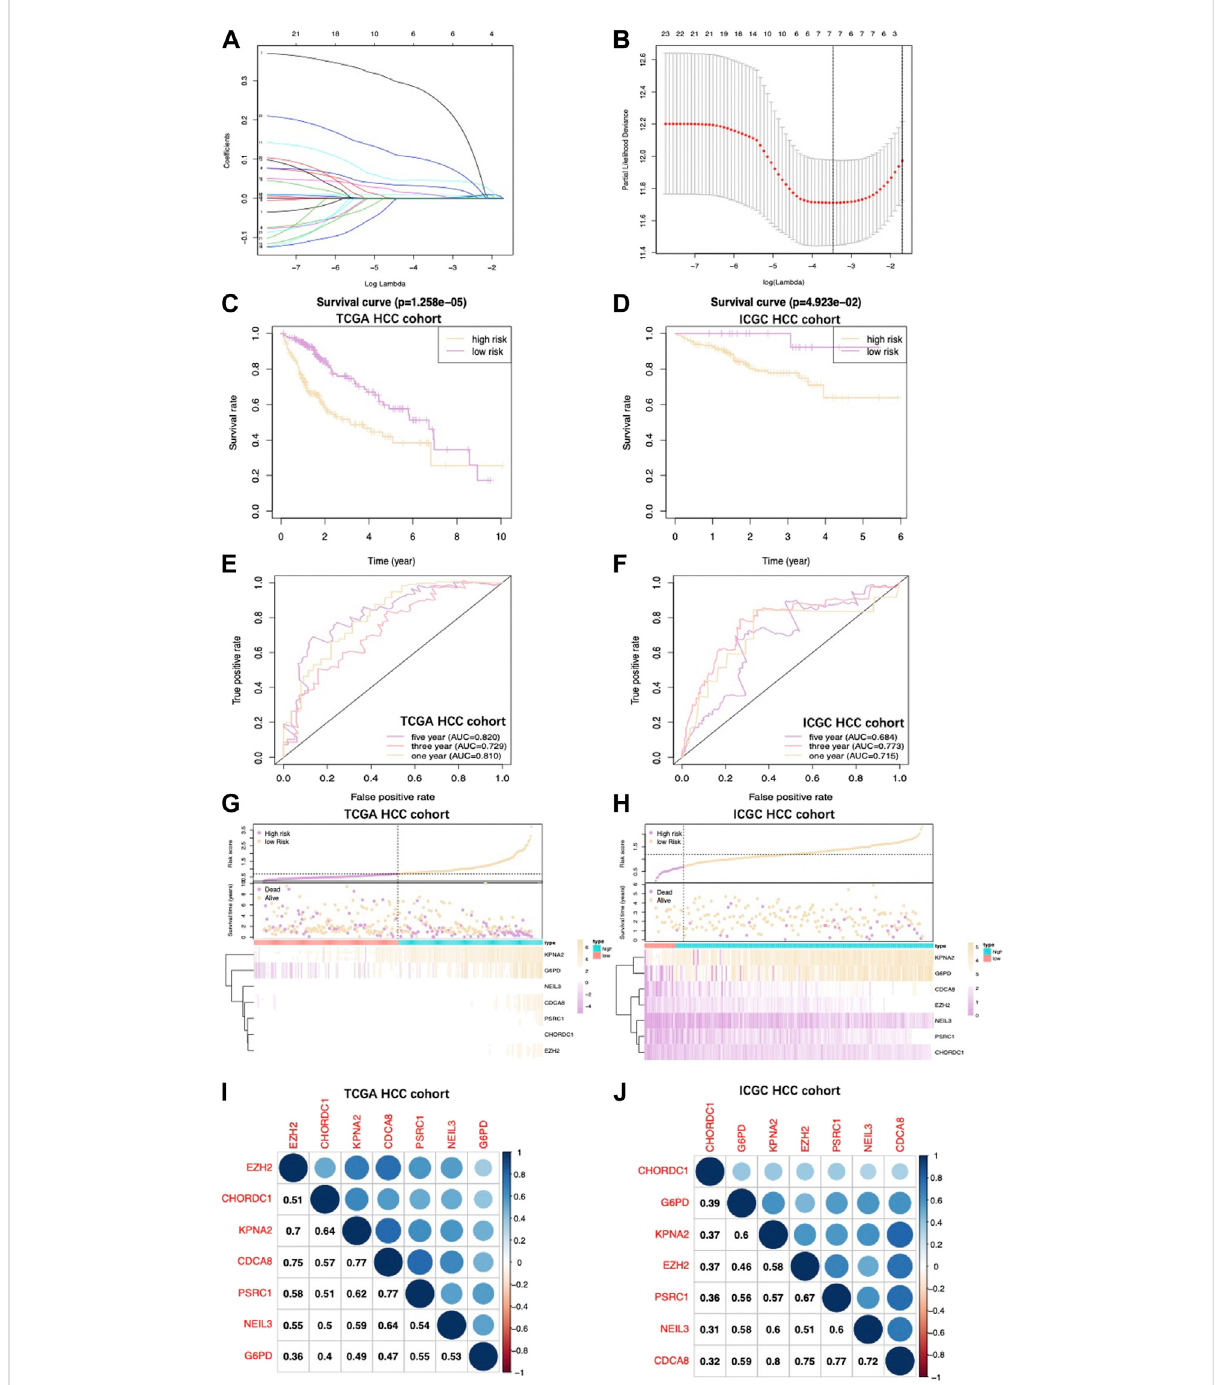
FIGURE 2 (A) Coef fi cient pro fi les obtained by LASSO analysis. (B) Screening for tuning parameter (lambda) based on the LASSO model through 10-fold cross-validation according to the minimal standards of OS, where log (lambda) is presented in the lower X -axis, while the mean OS gene quantity is shownintheupper X -axis,anddevianceerrorofpartiallikelihoodispresentedin Y -axis. Reddotsstandformeandevianceofpartiallikelihood ofthe modelwithspeci fi clambda,whereastheverticalbarsstandforupper/lowerlimitsofdevianceerrorsofpartiallikelihood.Verticaldottedlinesin blackde fi netheoptimallambdavaluewiththeoptimal fi t.Patientsurvivalcurvesfor twoHCCgroupsfromTCGA (C) togetherwiththosefromICGC (D) . High-risk group had shortened OS. (E) , (F) The survival-dependent ROC curves validated by 1-, 3-, and 5-year prognostic values for the prognostic index of TCGA and ICGC, separately. Risk score, OS, and gene expression distributions of (G) TCGA and (H) ICGC databases. Risk score, OS together with heatmap for seven gene levels in two groups are displayed in the fi gure upside down. The correlations of seven genes in the (I) TCGA database and (J) ICGC database are